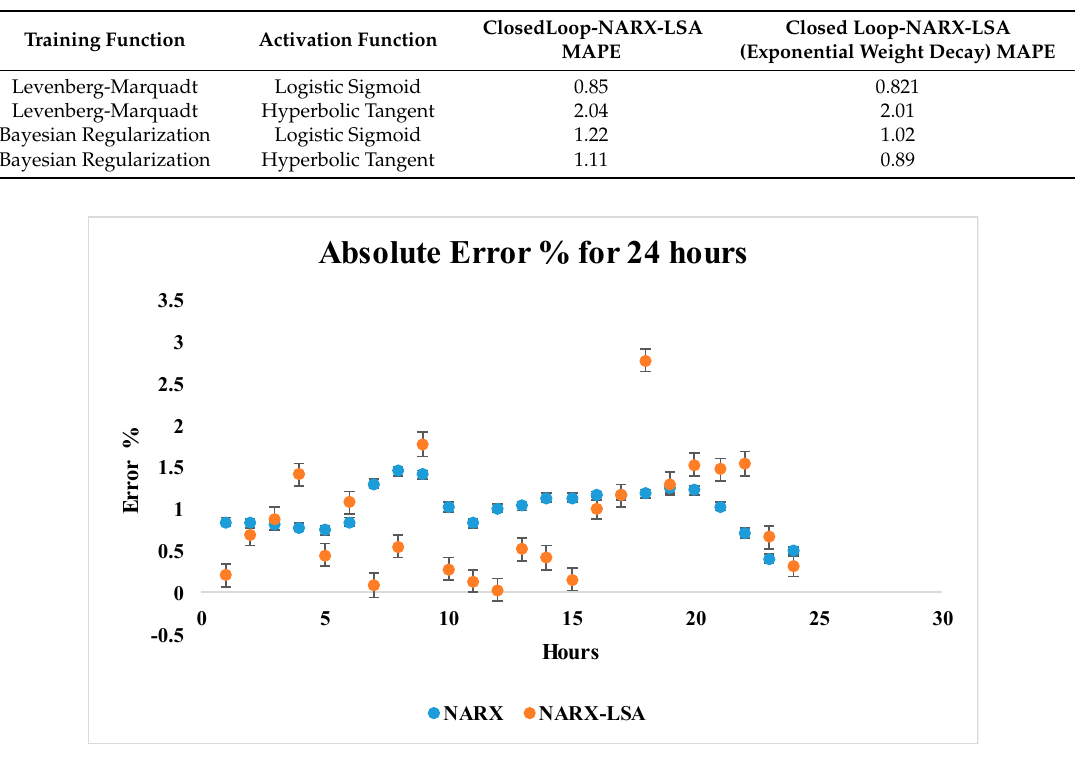
Figure 12. Error analysis NARX, NARX-LSA.